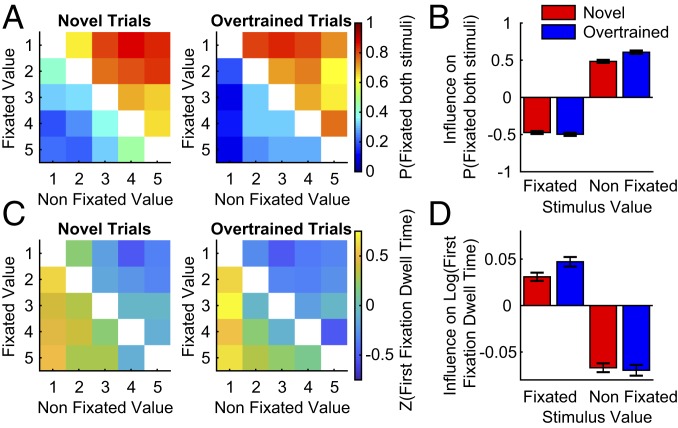
Subjects’ likelihood of fixating a second stimulus, and how long they dwell on their first fixation, is influenced by covert evaluation of the nonfixated stimulus. (A) The proportion of trials where the subjects fixated both stimuli, as a function of the first fixated and nonfixated stimulus values. (B) Logistic regression coefficients (±SE) of the probability of fixating both stimuli as a function of the first fixated and nonfixated stimulus values. (C) The z-scored dwell time on the first fixated stimulus on trials where both stimuli were viewed. The dwell time is a function of the fixated and nonfixated stimulus values. (D) Linear regression coefficients (±SE) of the log-transformed first stimulus dwell time as a function of fixated and nonfixated stimulus values.